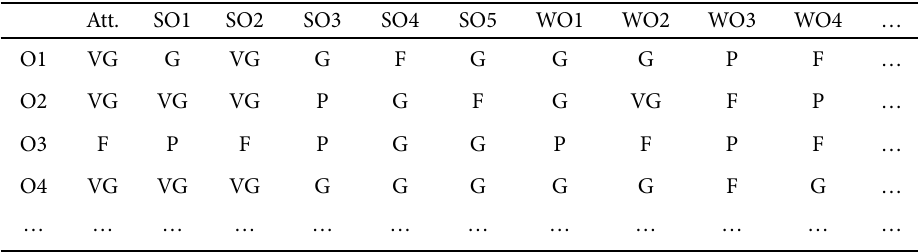
Table 5. A part of the original QSPM matrix